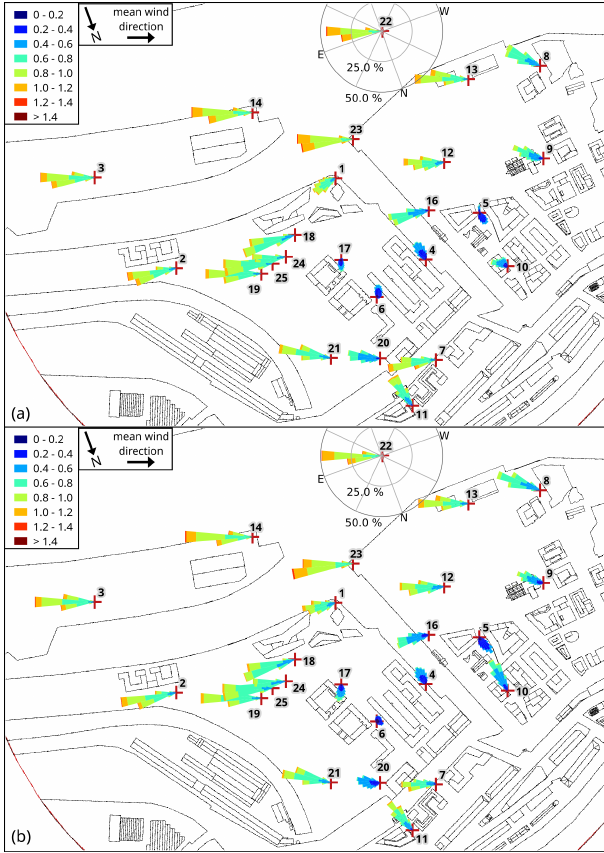
Figure 8. Wind-speed distribution (wind rose plots) at all measure- ment stations for (a) wind-tunnel measurements and (b) the PALM simulation at about 3m height above street level (wind tunnel: 3m, PALM: 2 . 5m). Axes are only shown for a single station for bet- ter overview, but all wind distributions are scaled equal. Numbers indicate the station number.